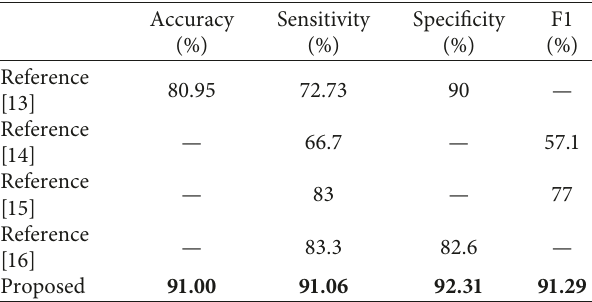
Table 3: Comparison with other methods of depression classifi- cation based on fusion signals.